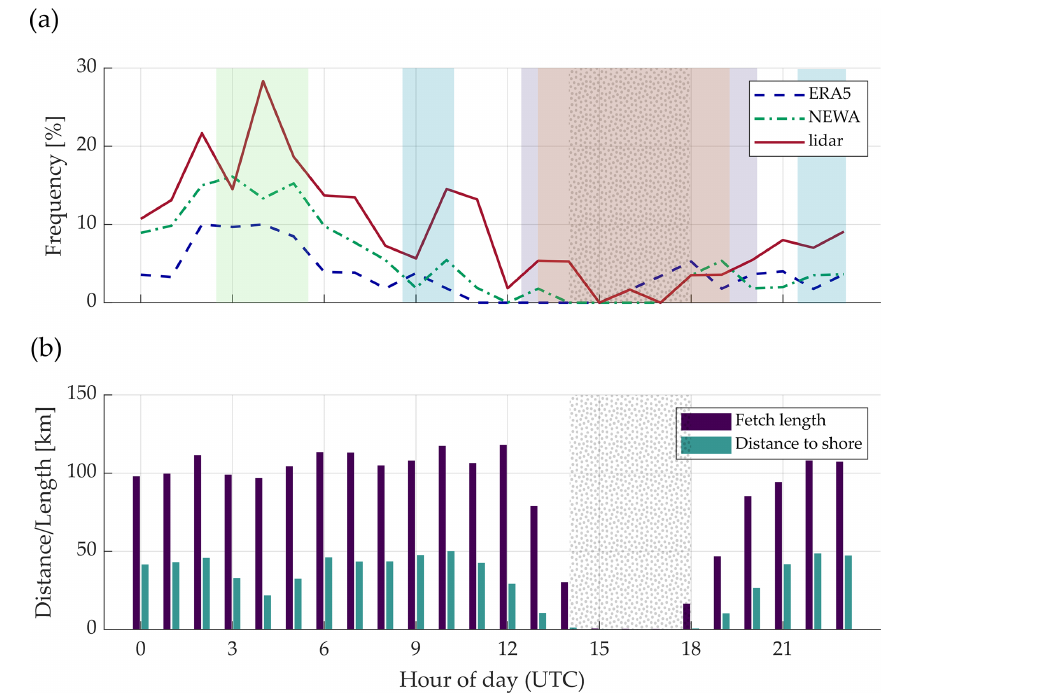
Figure 7. Hourly frequency of low-level jet occurrence (a) and mean distance to shore/fetch length for each hour (b) . The grey dotted area indicates the time interval when the ship is in the harbor. The colored shadowed areas refer to the periods where the ship is at the locations indicated in Fig.